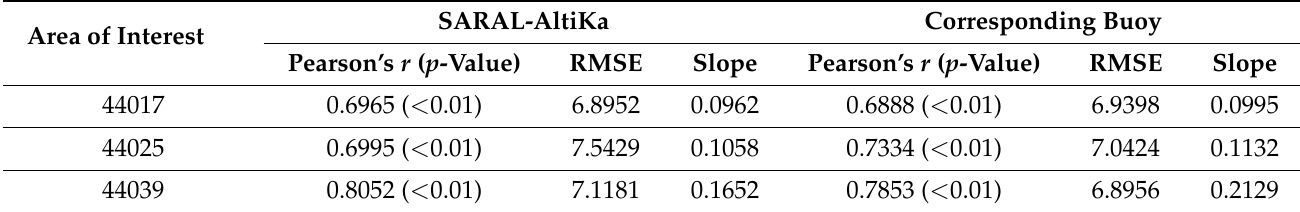
Table 4. Satellite and corresponding buoy Pearson correlation and RSME values between wind speed and ln ( H s ) . Area of Interest